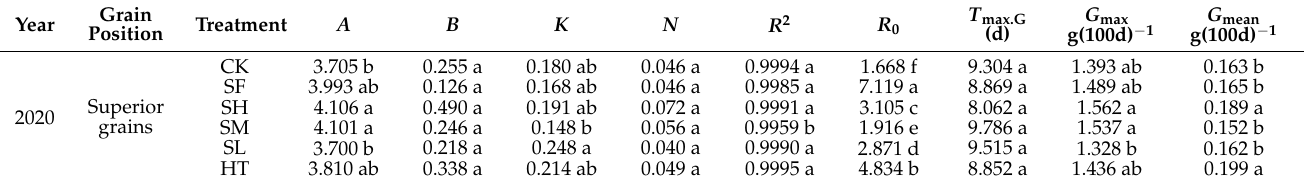
Table 2. Effect of rice straw combined with inorganic fertilizer on grain-filling